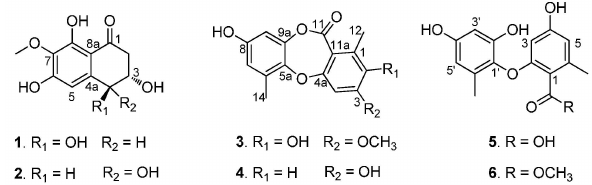
Figure 1. Compounds 1 – 6 isolated from the sponge-derived fungus Corynespora cassiicola